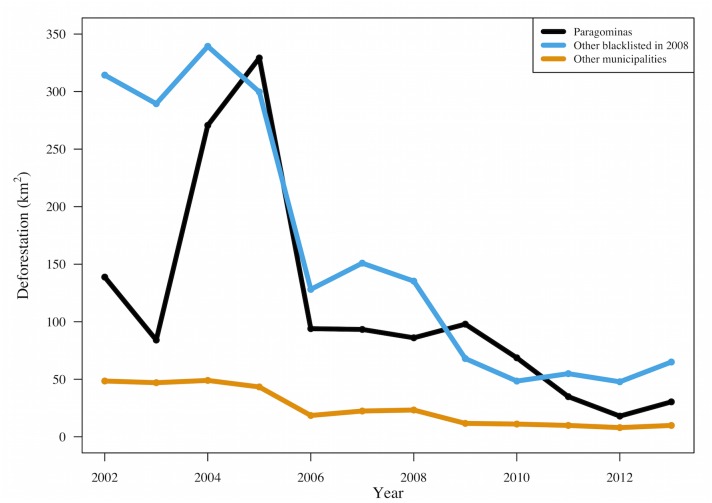
Average Annual Deforestation (KM2) per Municipality.